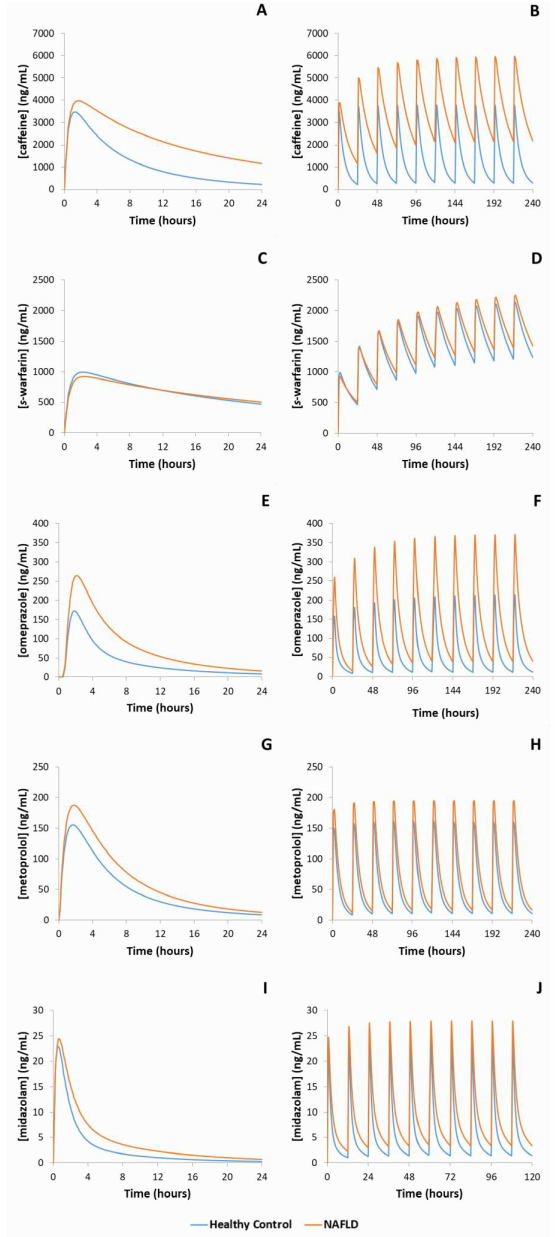
Figure 1. Representative mean simulated concentration-time profiles of probe substrates metabolised by each of the major cytochrome P450 enzymes. Blue line represents healthy control population, orange line represents MAFLD populations. ( A ): caffeine (CYP1A2), single dose; ( B ): caffeine, multiple doses; ( C ): s-warfarin (CYP2C9), single dose; ( D ): s-warfarin, multiple doses; ( E ): omepra- zole (CYP2C19), single dose; ( F ): omeprazole, multiple doses; ( G ): metoprolol (CYP2D6), single dose; ( H ) : metoprolol, multiple doses, ( I ): midazolam (CYP3A4), single dose; ( J ): midazolam, multiple doses.